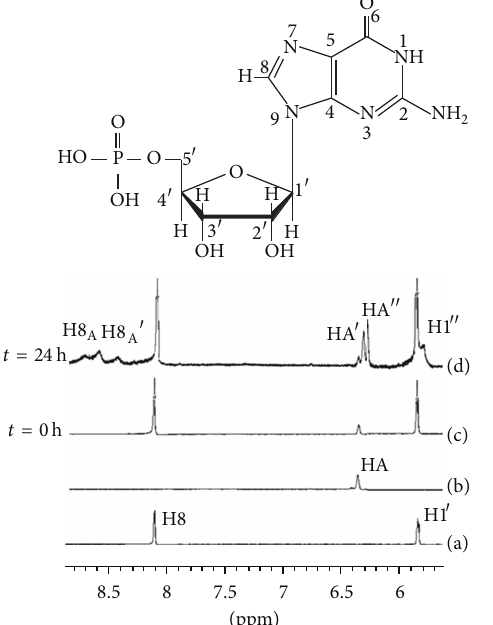
Figure 3: Selected 1 H NMR spectra for GMP (a), complex PtL c Cl 2 (b), the reaction of complex PtL c Cl 2 with 3 equiv. of 5 󸀠 -GMP in D 2 O after being incubated at 37 ∘ C for 0 h (c) and 24 h (d), respectively.